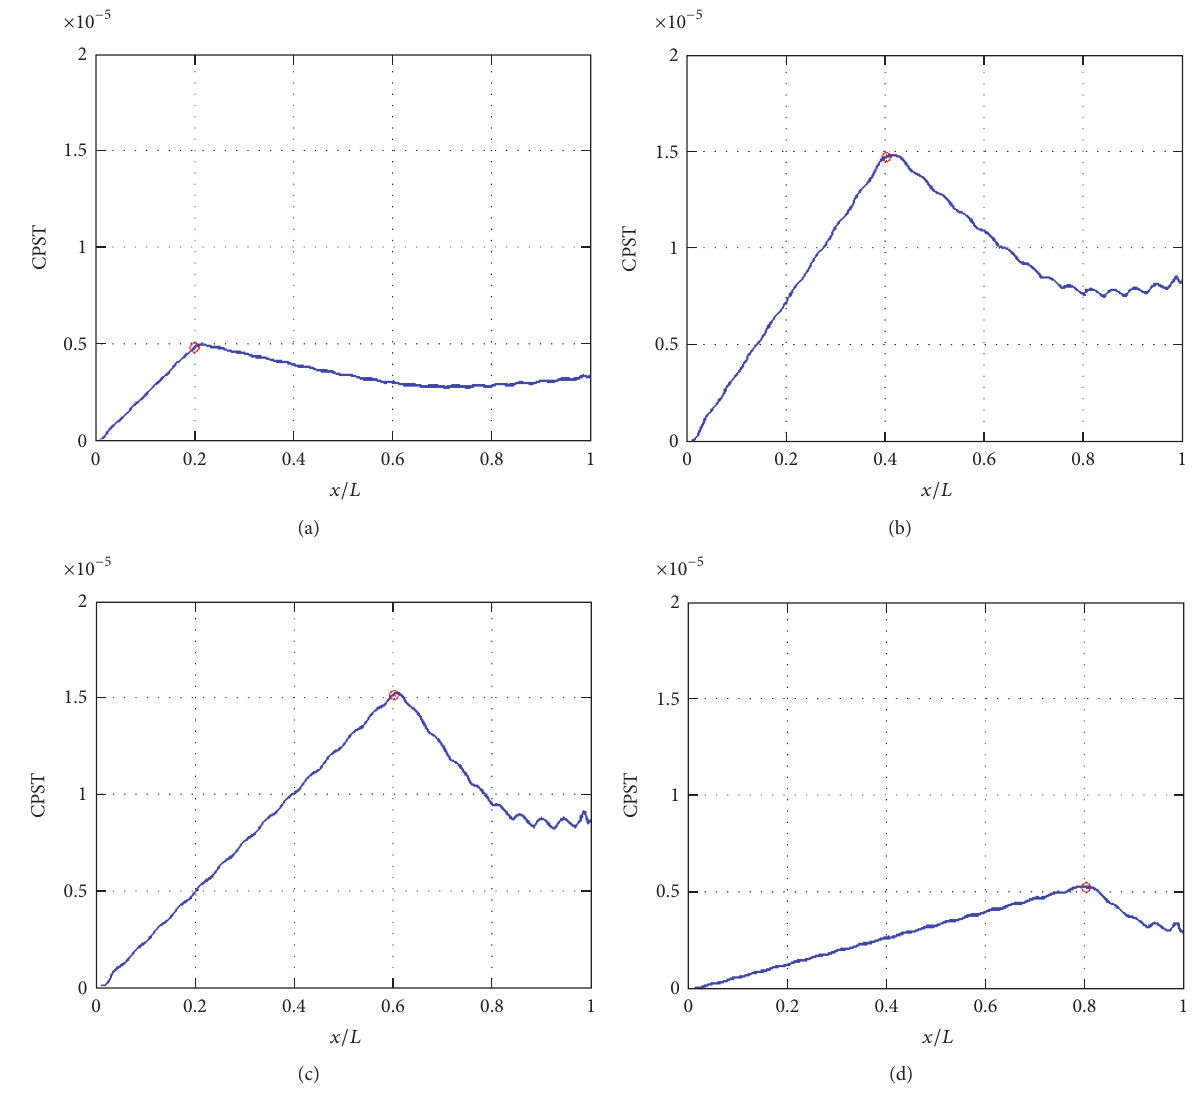
Figure 20: CPST of 10% damaged scenario using displacement responses with the mass which is 200Kg and velocity which is 1m/s: (a) damage location is 𝐿 𝑑 = 0.2 , (b) damage location is 𝐿 𝑑 = 0.4 , (c) damage location is 𝐿 𝑑 = 0.6 , and (d) damage location is 𝐿 𝑑 = 0.8